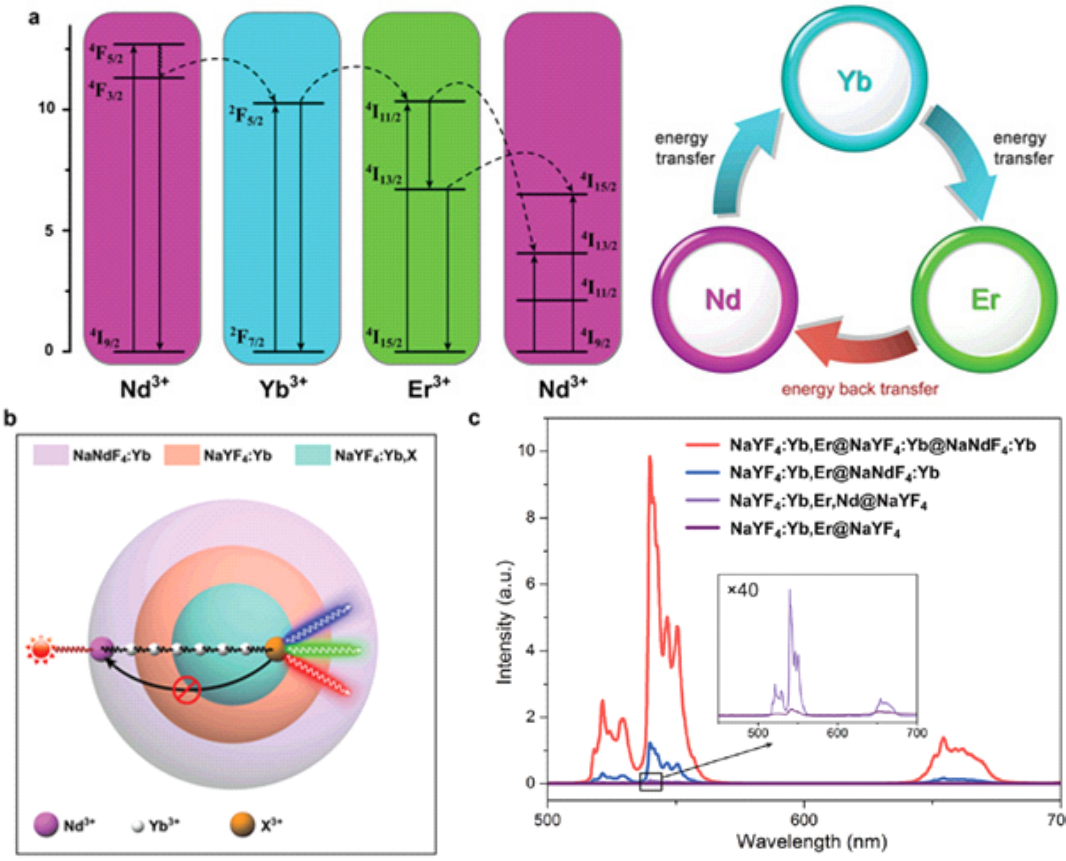
Figure 5. Bright upconversion under 800 nm excitation by engineering core@shell@shell structure. ( a ) Simplied energy-level diagrams depicting the energy transfer between Nd, Yb, and Er ions upon 800 nm excitation. ( b ) Schematic illustration of the proposed energy transfer mechanisms in the quenching-shield sandwich-structured UCNPs, ( c ) upconversion emission spectra of the as-synthesized UCNPs. Reproduced with permission from